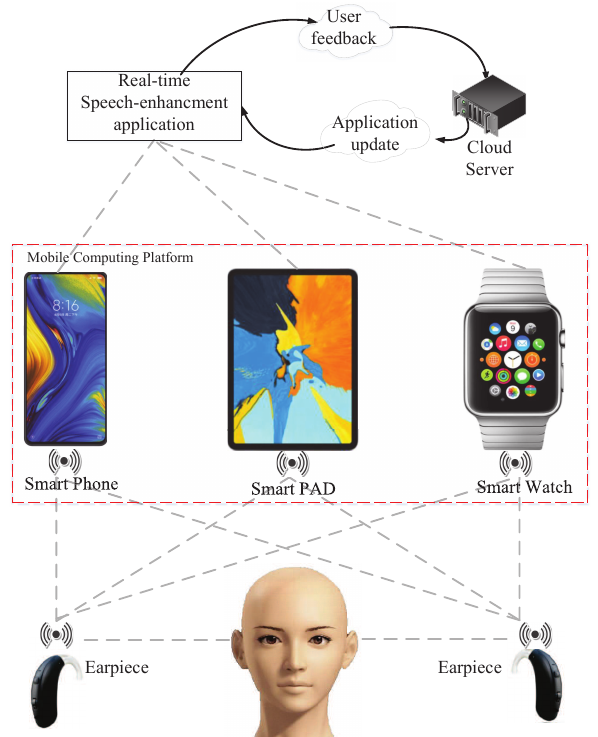
Figure 3. Proposed architecture of the